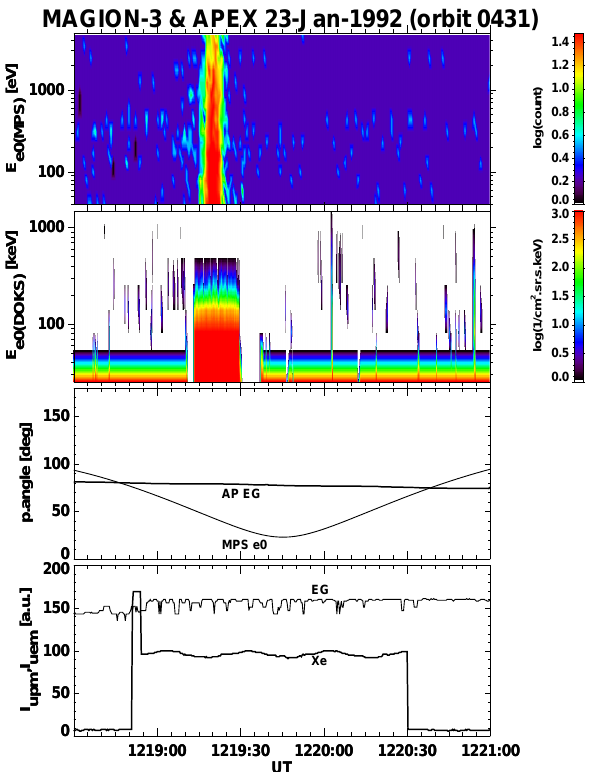
Fig. 1. Parameters of the electron burst observed during orbit No. 431. (From top to bottom: E e0 ( MPS ) , dynamic spectrogram up to 5keV measured in direction parallel to the satellite axis by the MPS device; E e0 ( DOKS ) , dynamic spectrogram up to 1 MeV measured in the same direction by the DOK device; p.angle, the pitch angle of both aforementioned channels (MPS e0) and pitch angle of the elec- tron gun on board the IK-25 satellite (AP EG); I upm , I uem , monitors of electron (EG) and ion (Xe) guns on board IK-25 satellite.